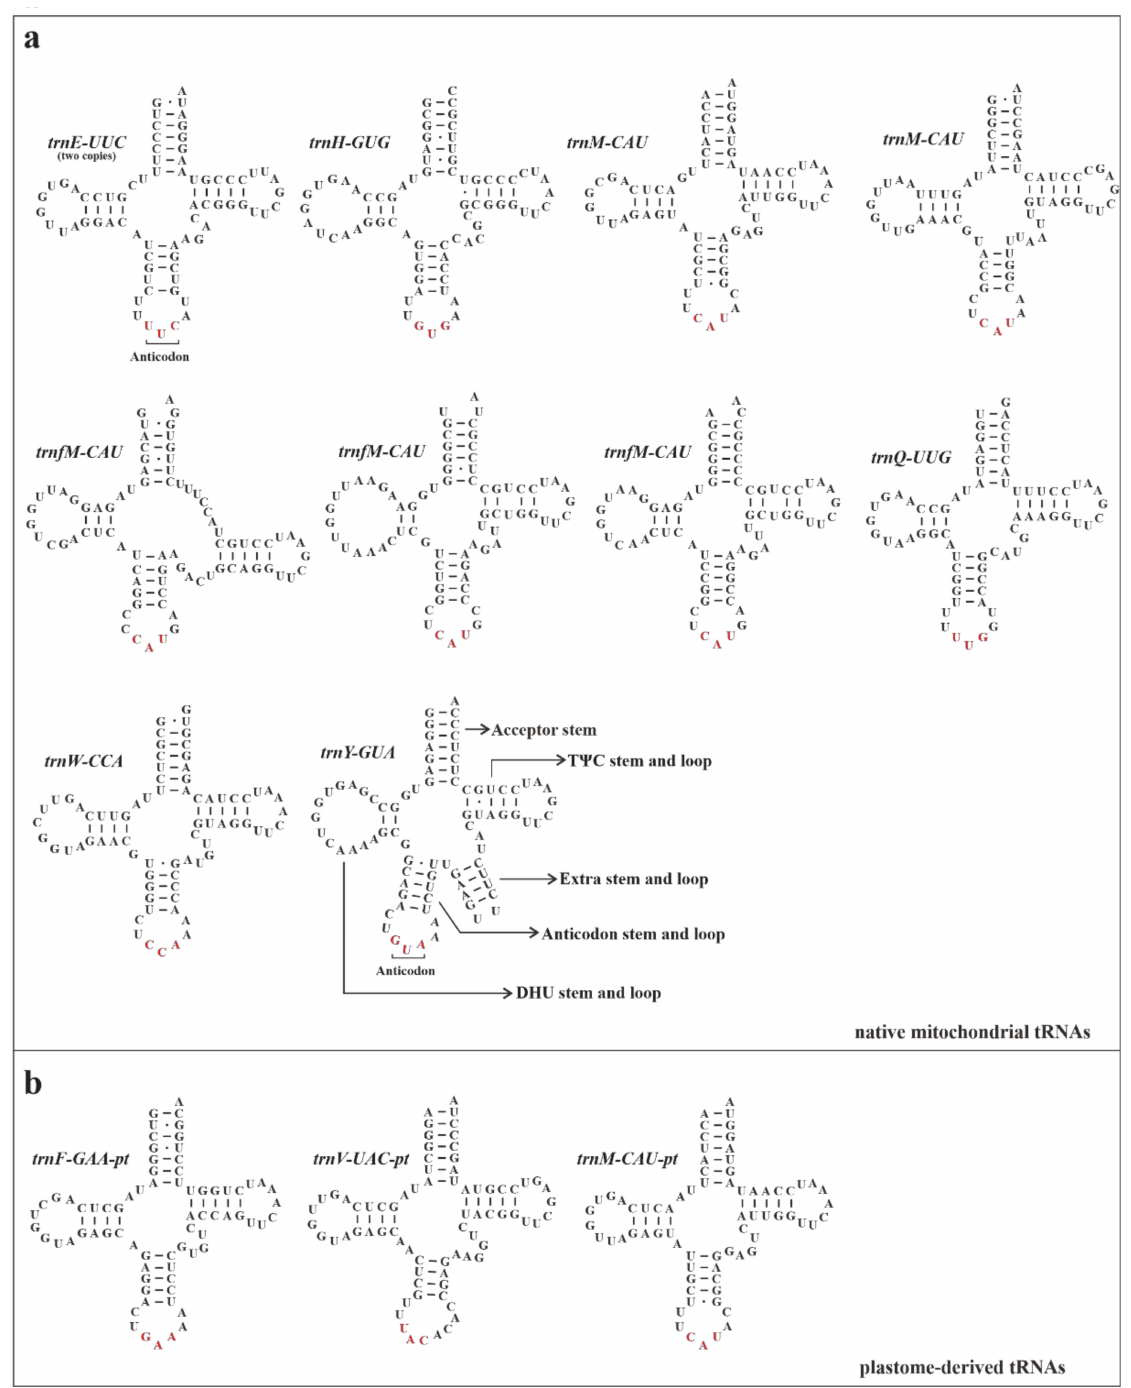
Figure 6. The predicted secondary structures of tRNAs found in mitogenome of S. plumbizincicola : ( a ) native mitochondrial tRNAs; ( b ) plastome-derived